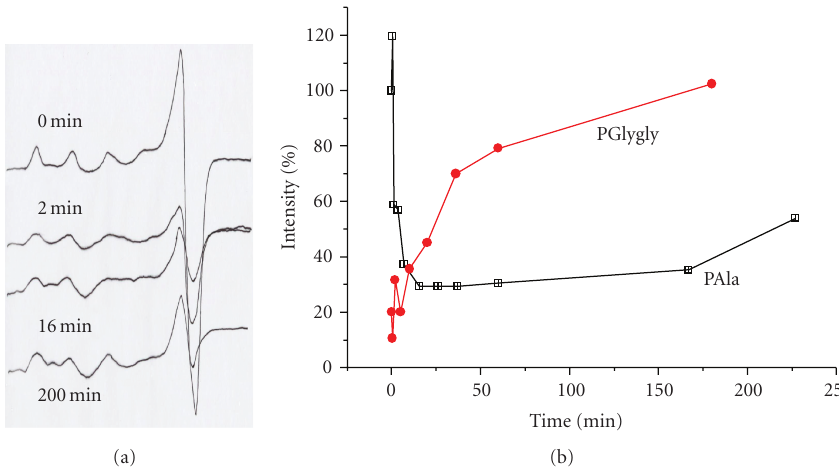
Figure 5: (a) EPR spectra of a frozen solution (77K) of PAla-Cu(II) at di ff erent reaction times. [Cu(II)] = 1 . 0 × 10 − 3 M, R = [PAla] / [Cu(II)] = 4, pH = 8 . 7. (b) The variation of the intensity of Cu(II) signal, as (%) of the initial signal ( t = 0min), during the reaction time for the systems Pala-Cu(II) and